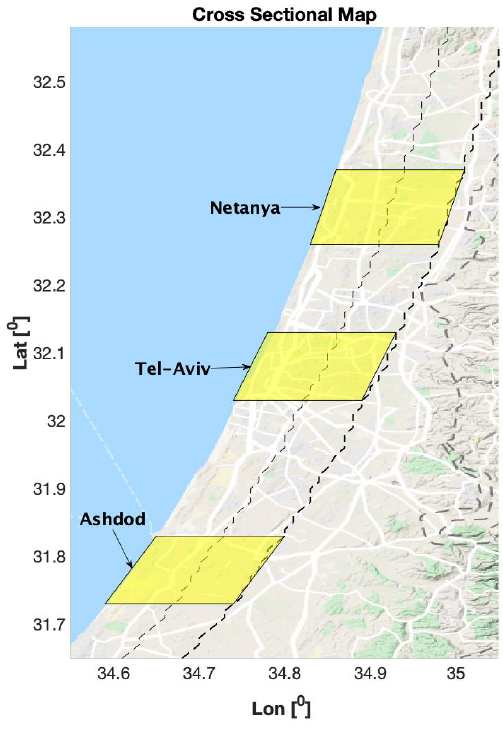
Figure 5. The boundaries of the strips representing the area on which the cross-sectional averages were drawn in Figure 6 are shown. Two NE – SW strips along the coast (dashed line) and three W – E strips around the three cities, Netanya, Tel-Aviv, and Ashdod (yellow parallelograms), are plotted.